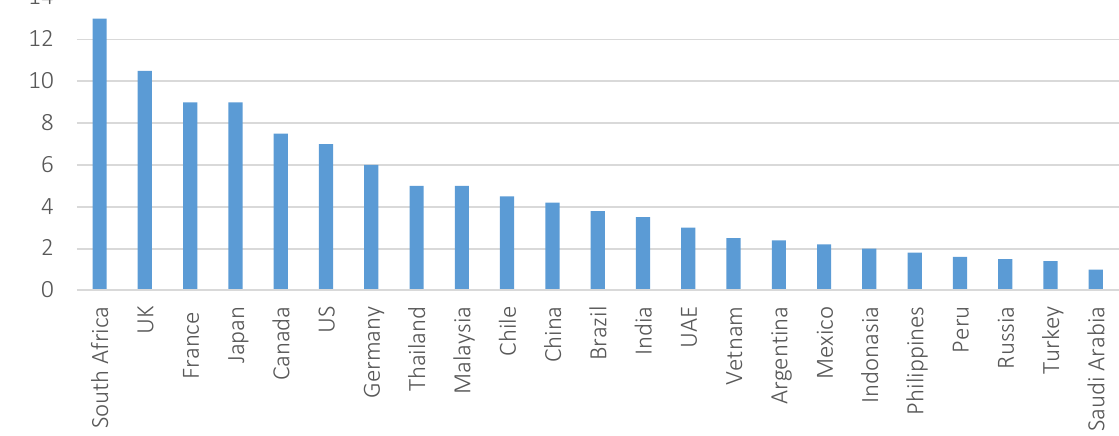
Figure 1. Insurance Penetration: Premiums as Percent of GDP, 2018 (in